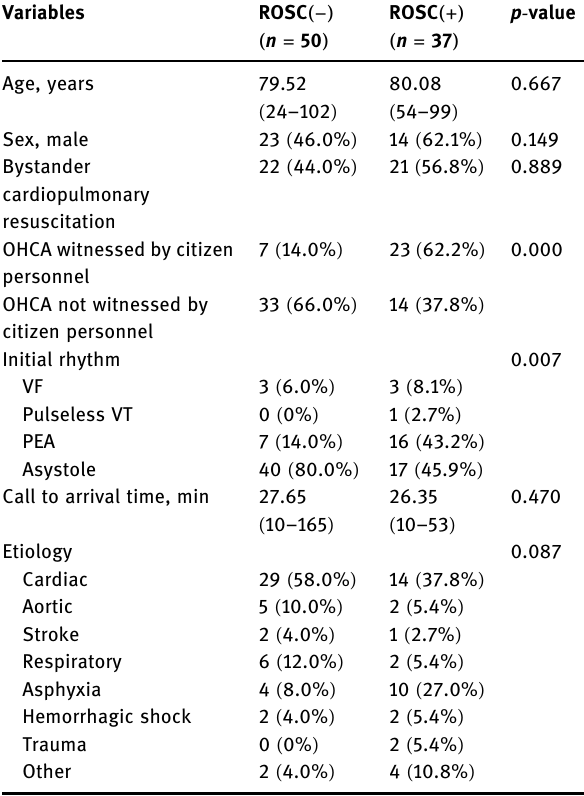
Table 1: Characteristics of the patients with OHCA